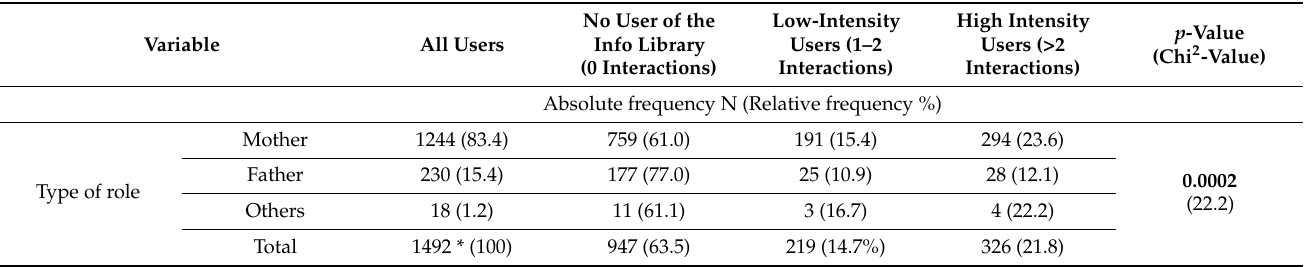
Table 3. Use of documentation function depending on the status of parents, education, age, and children.